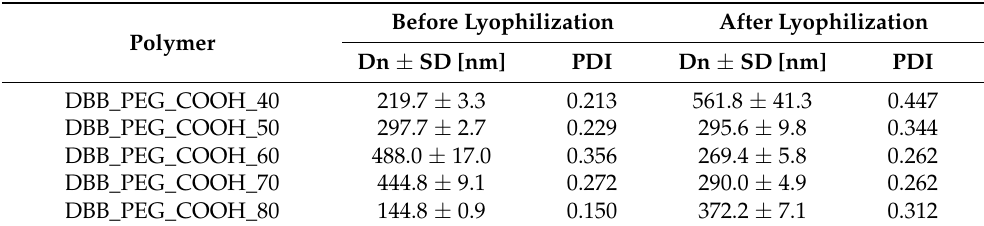
Table 3. The sizes of polyDBB_PEG_COOH micelles determined at maximum polymer concentration.